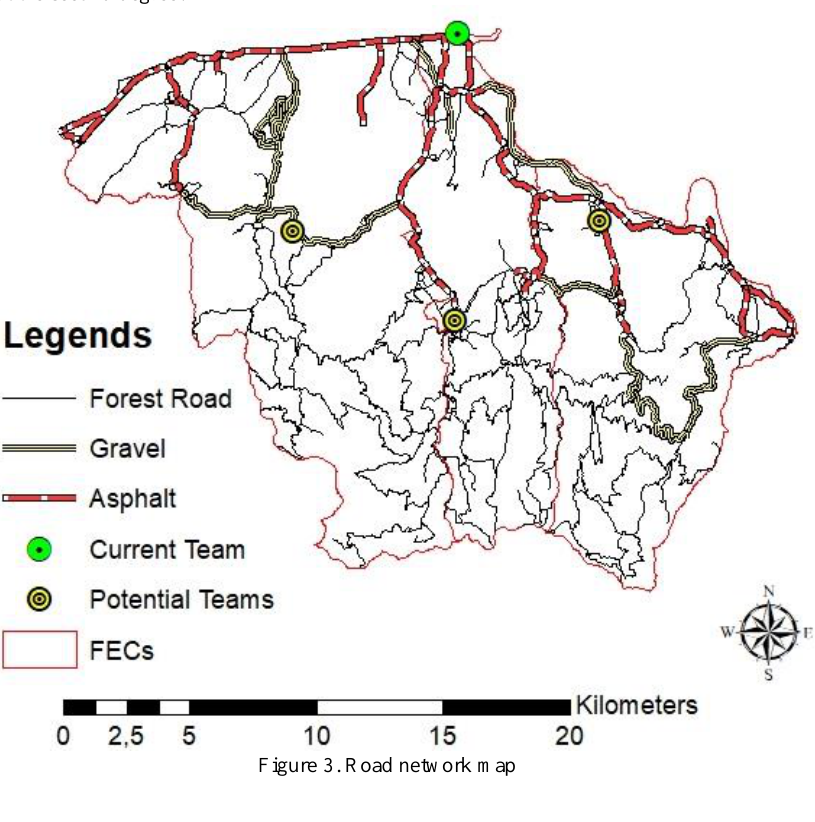
Figure 3. Road network